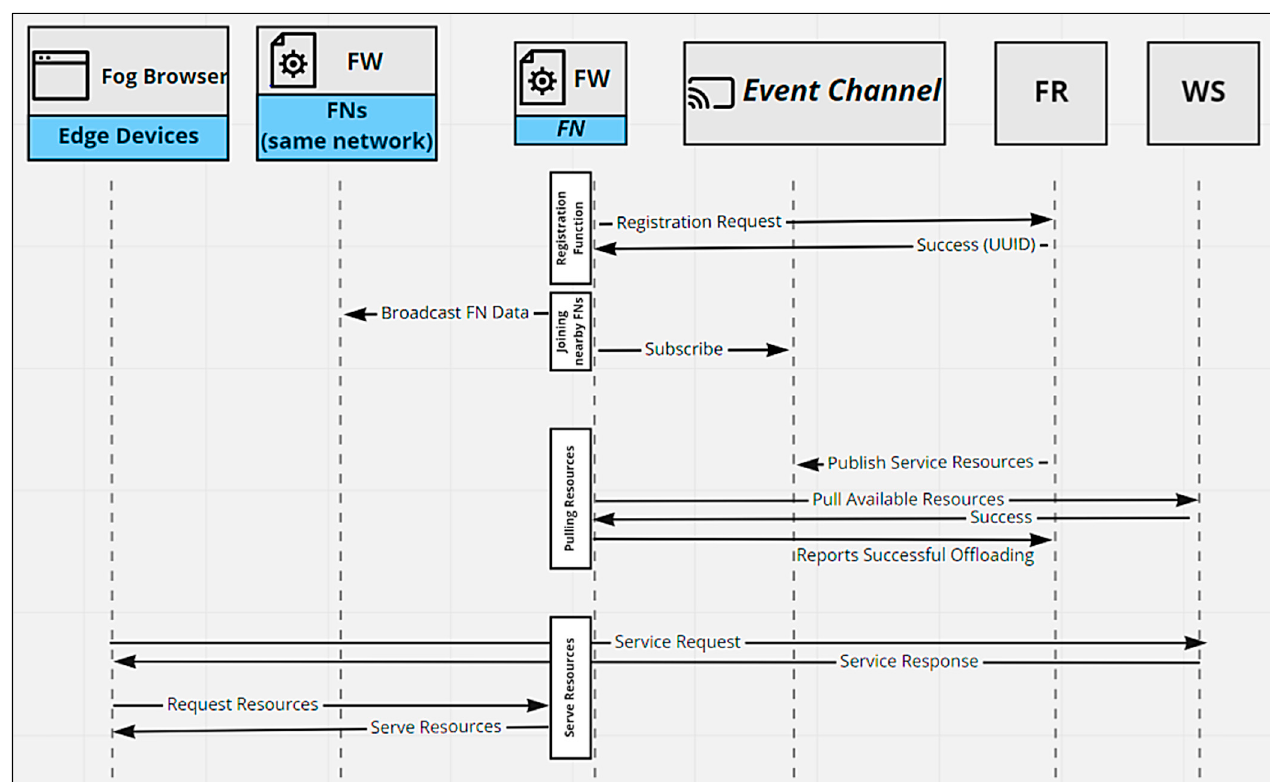
Figure 5. Functions of the Fog Worker in a sequence diagram.